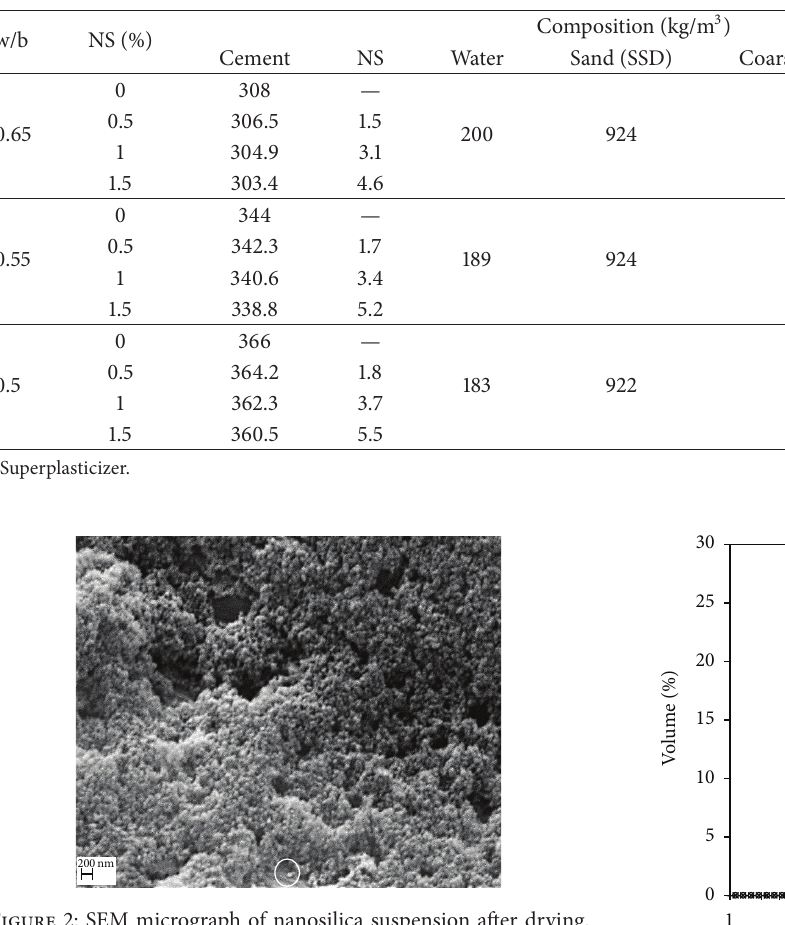
Figure 2: SEM micrograph of nanosilica suspension after drying. The white circle shows typical agglomerates of NS with size smaller than 100 nm.